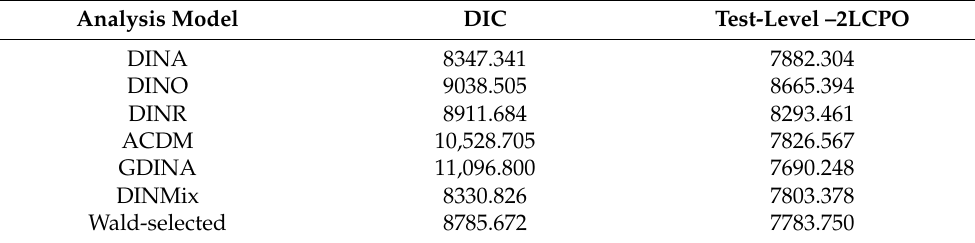
Table 4. The DIC and –2LCPO of Seven Models for the Fraction Subtraction Data.